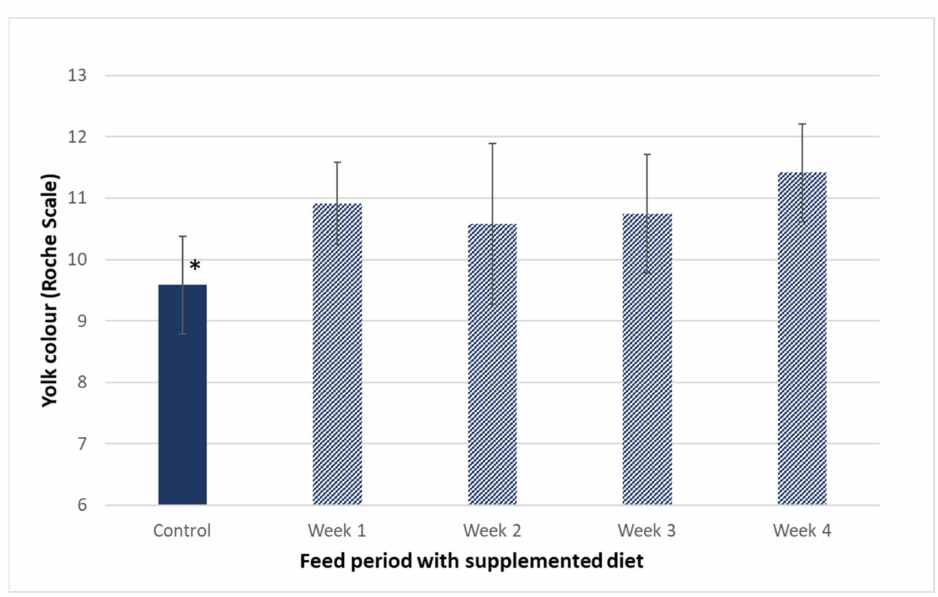
Figure 3. Yolk colour of eggs from hens fed with 3% of Nannochloropsis oceanica supplemented diet during the 4 weeks of the trial. * means statistically significant differences ( p < 0.05) (N = 12).